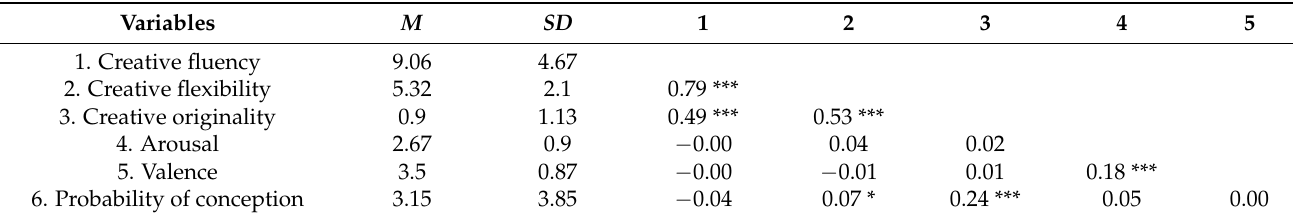
Table 1. Means, standard deviations and correlations among study variables, controlling for age, N = 751. Variables